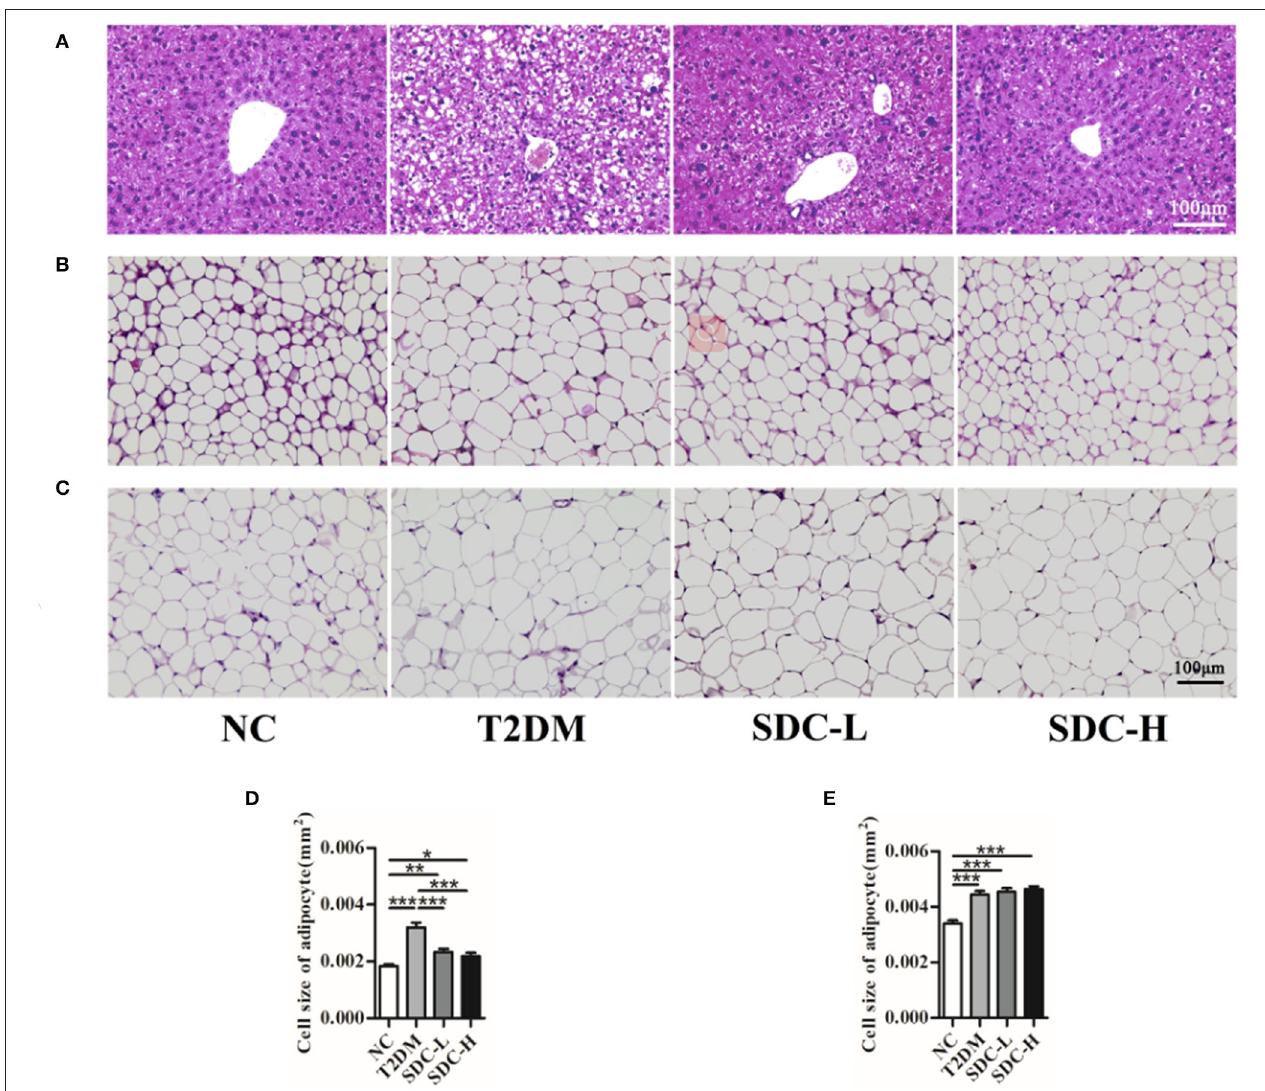
FIGURE 3 | Liver (A) , subcutaneous adipose (B) , and epididymal visceral adipose (C) histopathology; Cell size of subcutaneous adipose tissue (D) and epididymal visceral adipose tissue (E) . n = 10, * P < 0.05, ** P < 0.01, *** P <